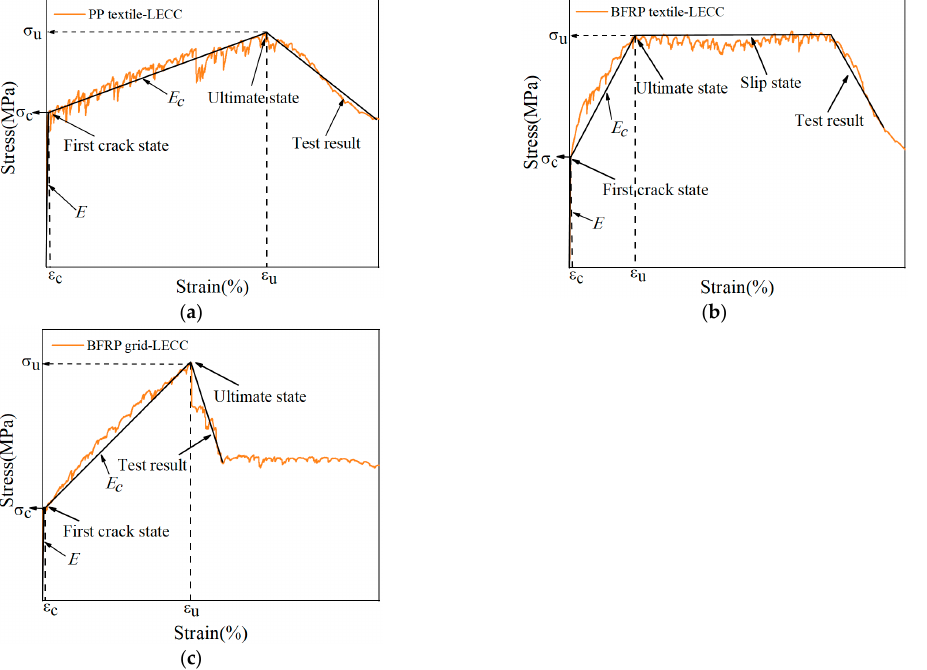
Figure 6. Stress–strain curve of reinforced textile type: ( a ) PP textile, ( b ) BFRP textile, and ( c ) BFRP grid.